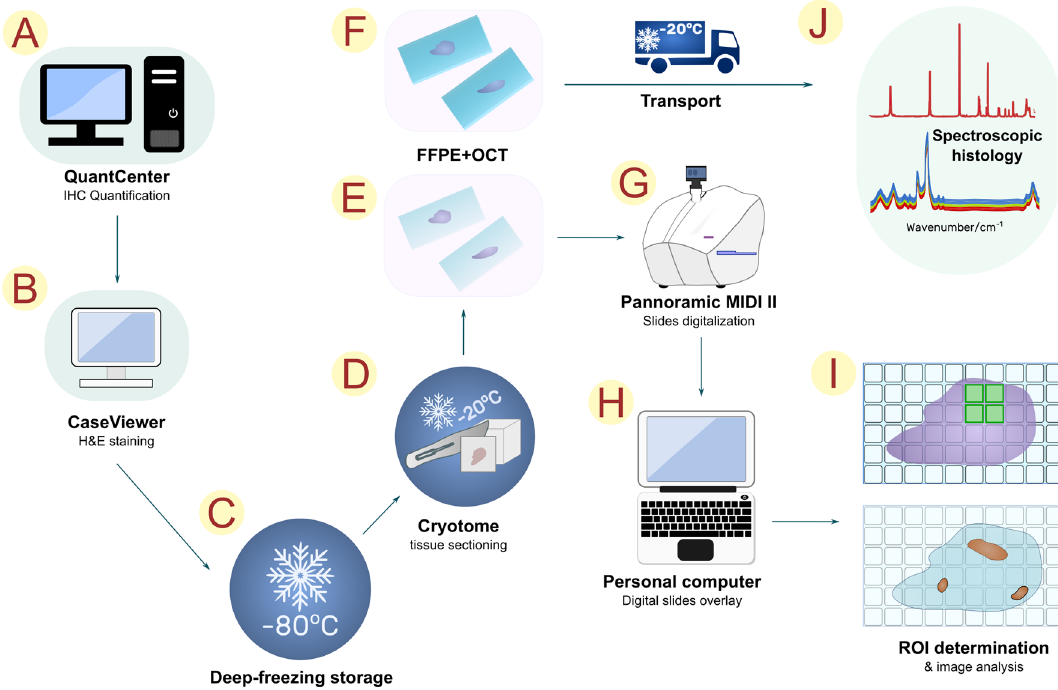
Figure 4. Schematic methodology for sample estimation. ( A ) Digital evaluation of formalin-fixed, paraffin- embedded (FFPE) slides of IHC expression against tested immune cell biomarkers. ( B ) Digital evaluation of homologous slides in standard hematoxylin and eosin (H & E) staining. ( CV ) Case selection of appropriate frozen tissue samples. ( D ) Tissue processing using the cryotome. ( E ) Adhesion of colon tissue sections to Superfrost glass slides for the validation of frozen tissue quality; H & E staining. ( F ) Tissue cross-sections mounted on Kevley slides for FFPE samples and frozen tissues fixed in optimal cutting temperature (OCT) compound for further spectroscopic assessment. ( G ) Scanning procedure for FFPE and H & E slides. ( H ) Selection of the most suitable areas of the colonic mucosa for spectroscopic analysis to assess GALT and inflammatory cells. ( I ) Spectroscopic examination of FFPE and OCT